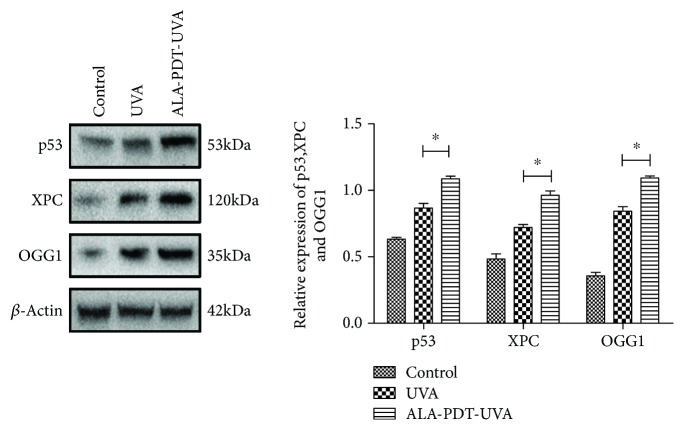
ALA-PDT pretreatment increased the levels of p53, XPC, and OGG1 proteins. Cells were treated with a sublethal dose of ALA-PDT, then these cells were irradiated with 10 J/cm2 of UVA light. A Western blot analysis was carried out to detect the expression levels of p53, XPC, and OGG1 proteins. Protein expression levels were quantified by using β-actin as control. Data were expressed as mean ± SD, n = 3 for each group, ∗p < 0.05.